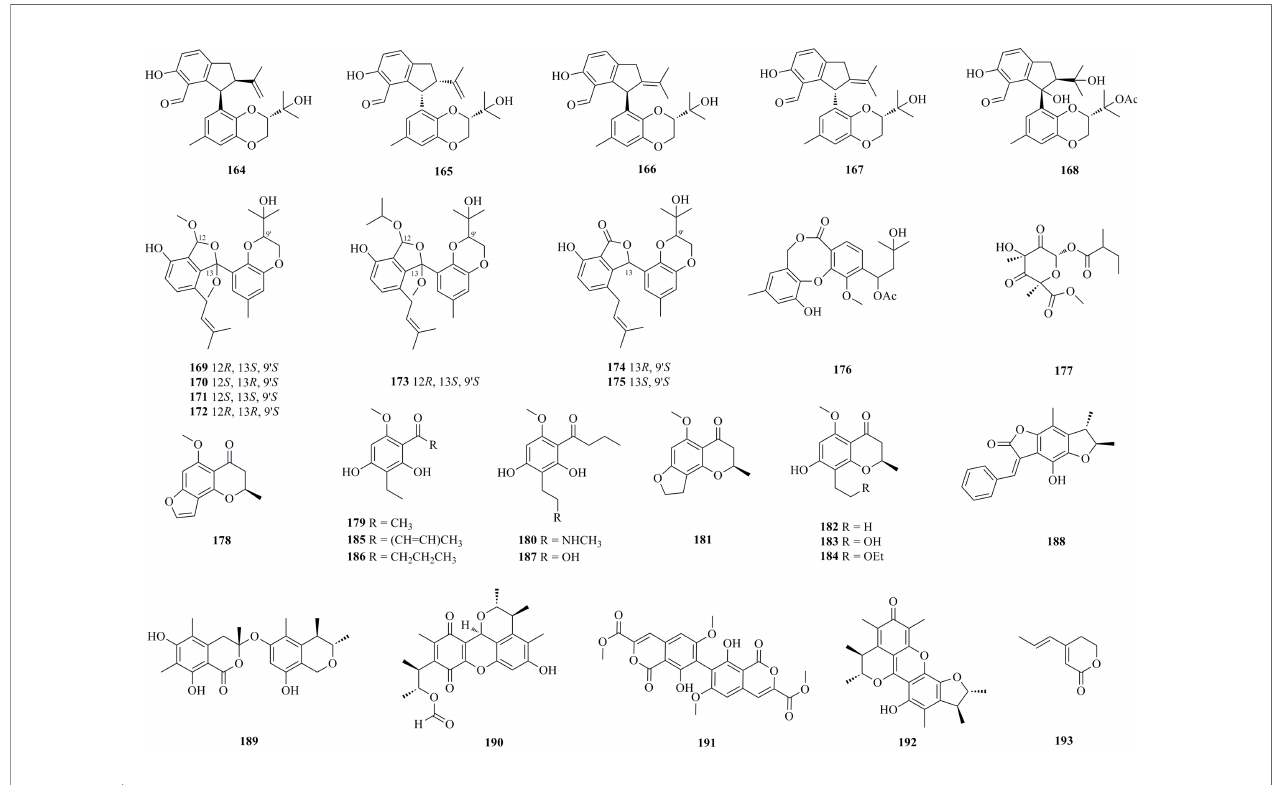
FIGURE 10 | Other polyketides isolated from deep-sea fungi ( 164 − 193 ).